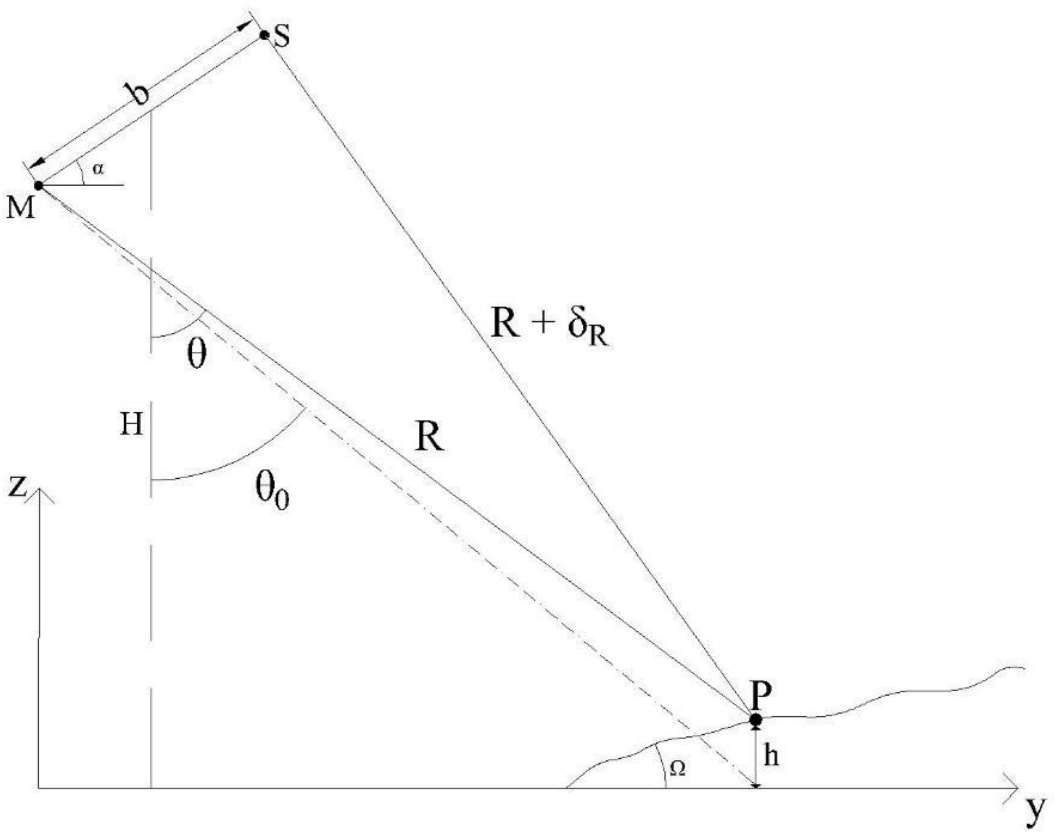
Figure 2. InSAR geometry acquisition. M and S represents the positions of master and slave acquisitions, respectively, and P is the generic point target on the ground.